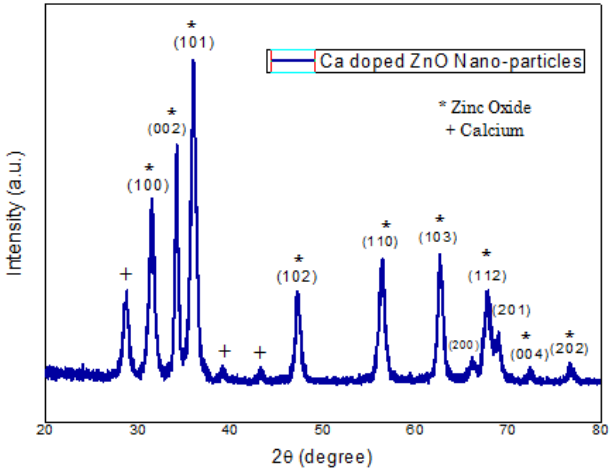
Figure 8. XRD spectra of Ca-doped ZnO nanoparticles. Figure 8 . XRD spectra of Ca‐doped ZnO nanoparticles . Figure 8 . XRD spectra of Ca‐doped ZnO nanoparticles .